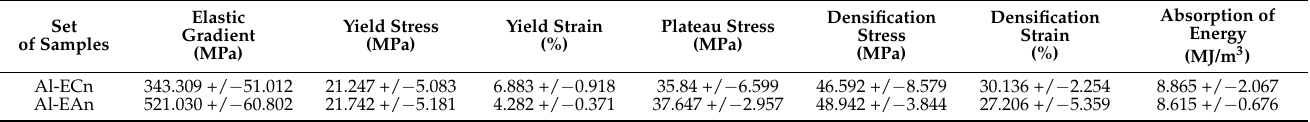
Table 5. Average and deviation of mechanical properties estimated based on the guidelines of the ISO-13314 standard [31].